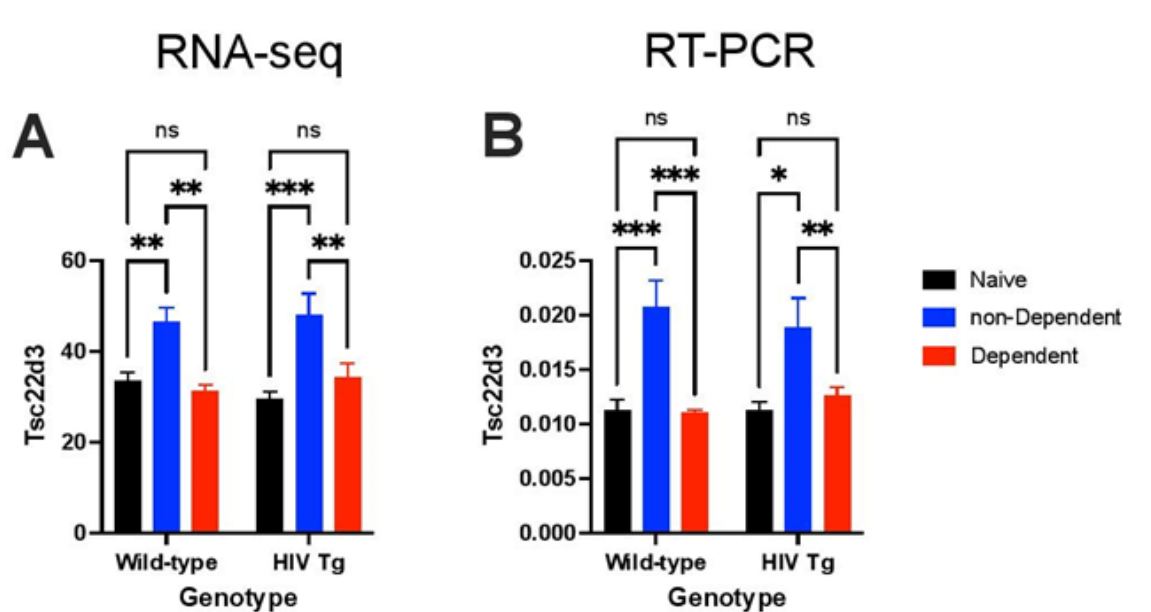
Figure 3. Differential expression of the glucocorticoid-responsive gene Tsc22d3 ( Gilz ) by histories of nondependent (ShA) and dependent (LgA) oxycodone self-administration in HIV Tg rats and WT rats. ( A ) RNA-sequencing expression of the glucocorticoid-responsive gene Tsc22d3 ( Gilz ) increased in both HIV Tg rats and WT rats with histories of oxycodone self-administration under ShA conditions compared with their respective oxycodone-naive controls, which was indicative of dysregulation of glucocorticoid-dependent gene expression associated with oxycodone self-administration. Tsc22d3 expression did not increase in HIV Tg rats or WT rats with histories of oxycodone self-administration under LgA conditions, consistent with adaptations that occur under conditions of chronic elevations of glucocorticoids [82,83] ( F 2,34 = 21.91, p < 0.0001, n = 6–7/group). ( B ) Consistent results were obtained by RT-PCR ( F 2,36 = 19.64, p < 0.0001, n = 7–8 /group). * p < 0.05, ** p < 0.01, *** p < 0.001 (Newman–Keuls post hoc test).